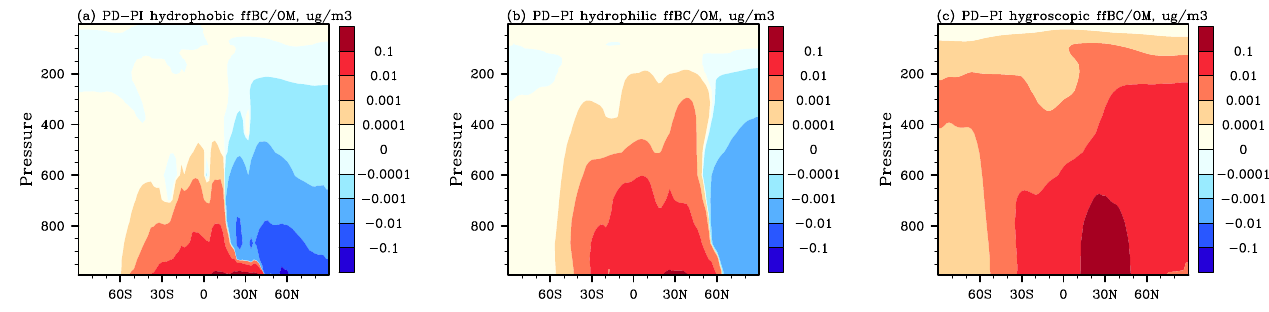
Fig. 4. PD–PI annual average changes of hydrophobic (a) , hydrophilic (b) , and hygroscopic (c) ffBC/OM (µgm − 3